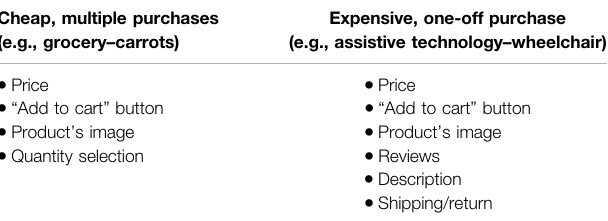
TABLE 7 | Important objects for e-commerce websites. Cheap, multiple purchases (e.g., grocery –